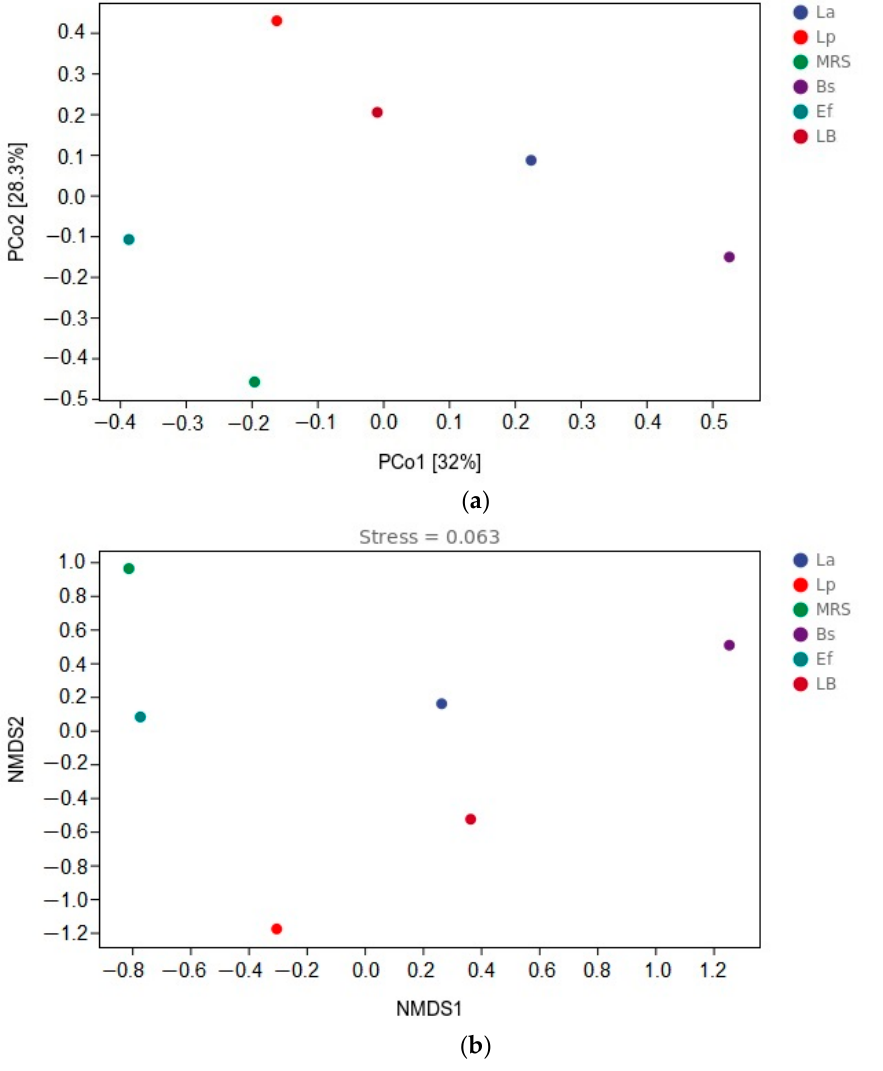
Figure 5. β -diversity analysis: ( a ) distance matrix and PCoA analysis; ( b ) β -diversity analysis and NMDS